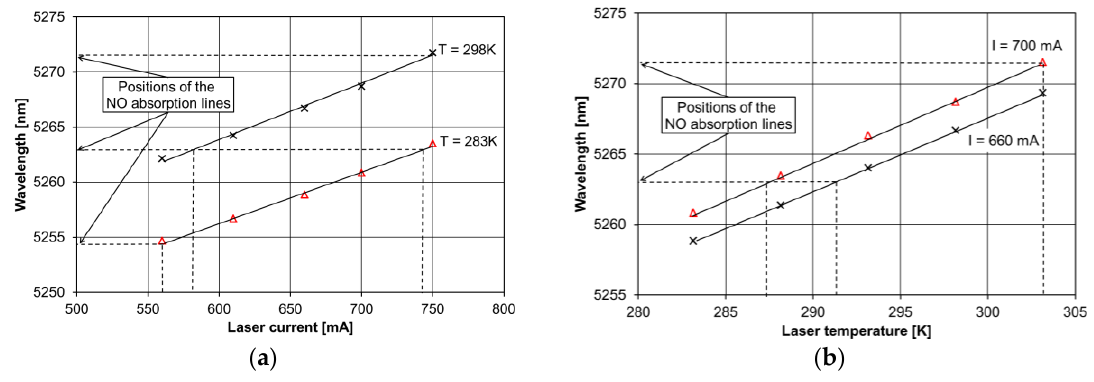
Figure 2. ( a ) Measurements results of the QCL current; and ( b ) the temperature influence on the QCL wavelength.